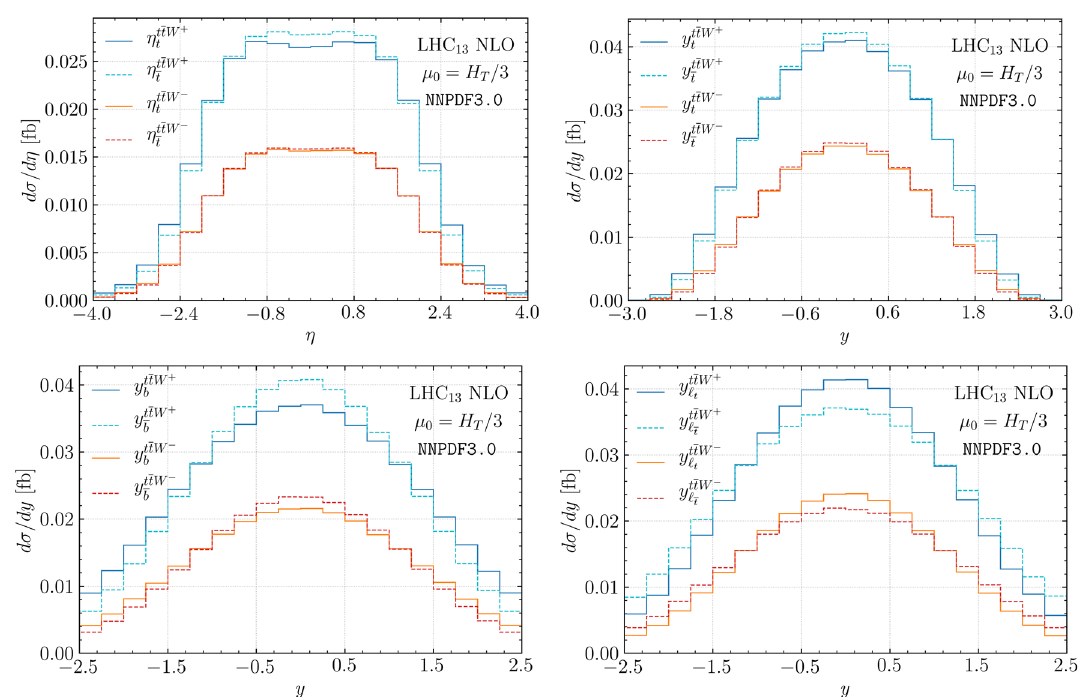
Fig. 4 Comparison of the rapidity and pseudo-rapidity distributions of the t and ¯ t quarks at the NLO QCD level for pp → t ¯ tW + and pp → t ¯ tW − in the multi-lepton final state. Also shown are rapid-